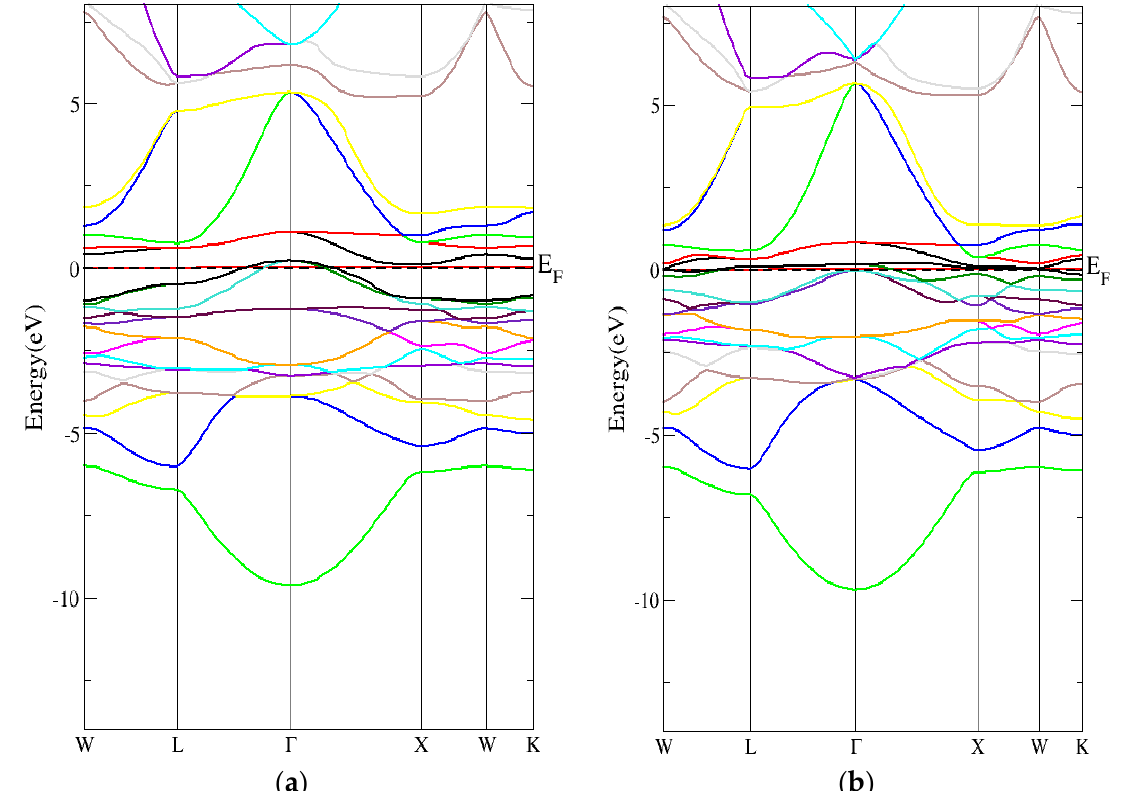
Figure 4. The band structure for the inverse Heusler Co 2 CrAl compound by employing the PBE-GGA technique for ( a ) spin-up inverse Heusler Co 2 CrAl compound and ( b ) spin-down inverse Heusler Co (cid:2870) CrAl compound.